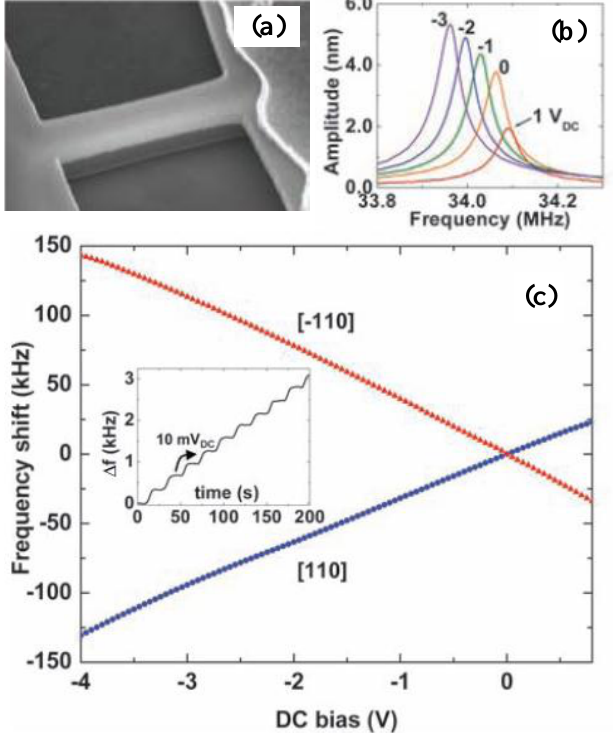
Figure 27. Piezoelectric resonant frequency control and tuning [42]. ( a ) Clamped-clamped beam which used to gauge the efficiency of piezoelectric excitation; ( b )